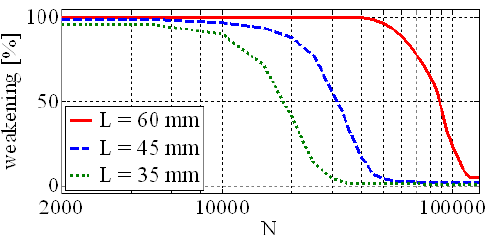
Figure 9. Performance degradation with a growing number of cy- cles for the different height adjustments of the fatigue test bench (at 1Hz).